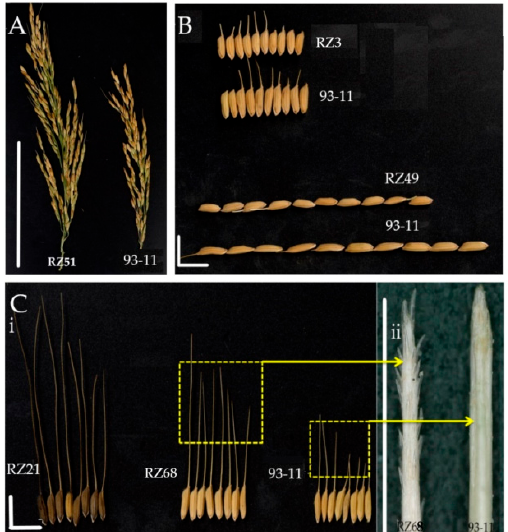
Figure 4. Phenotypic variation in the appearance of grains and awns in CSSLs and 93-11. ( A ) Grain number per ear for RZ50 and 93-11 (bar = 10 cm); ( B ) length of grains of RZ3 and 93-11 (bar = 1 cm); ( C ) Phenotypes of the awns of RZ21, RZ68 and 93-11: ( A ) awn length (bar = 1 cm) and ( C ) awn tip surfaces of RZ68 and 93-11 (bar = 1